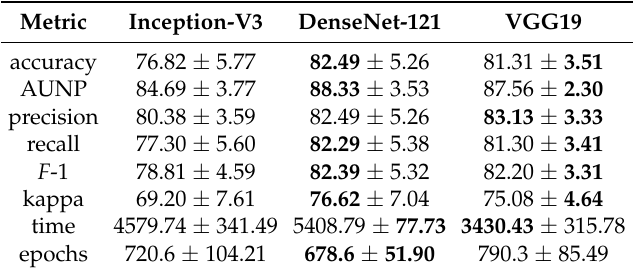
Table 7. Comparison of classification performance of CNN-TL-DE on different CNN